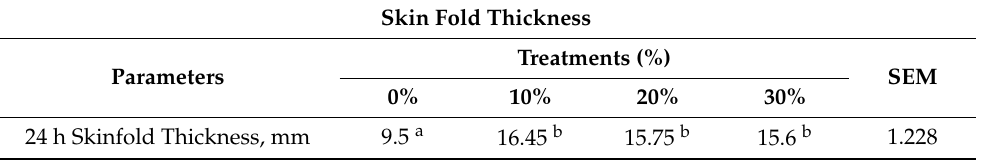
Table 6. Skin fold thickness after PHA challenge and relative quantification for select cytokines. Skin Fold Thickness